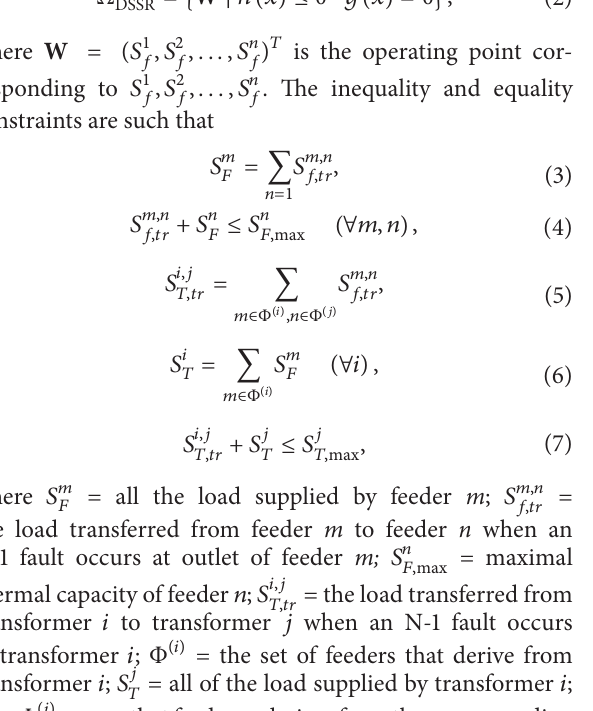
Figure 2: Feeder and transfer unit